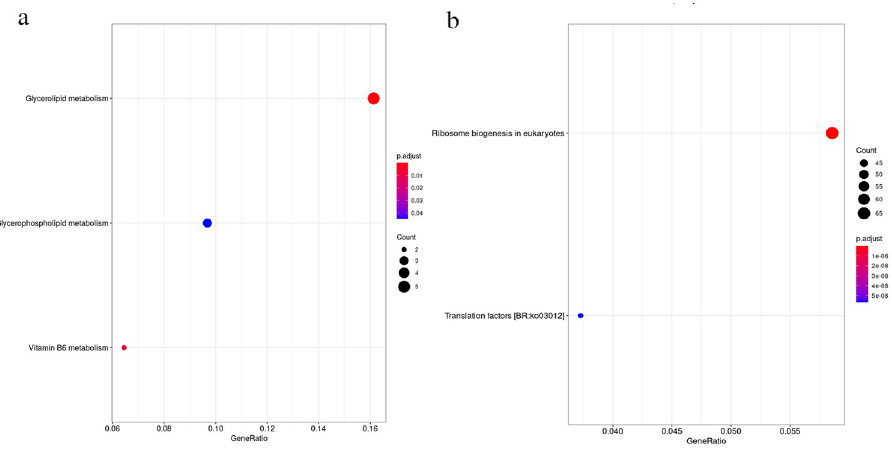
Fig 10. KEGG pathway analysis results of each module. (a) Genes in blue 4 module. (b) Genes in lightlateblue